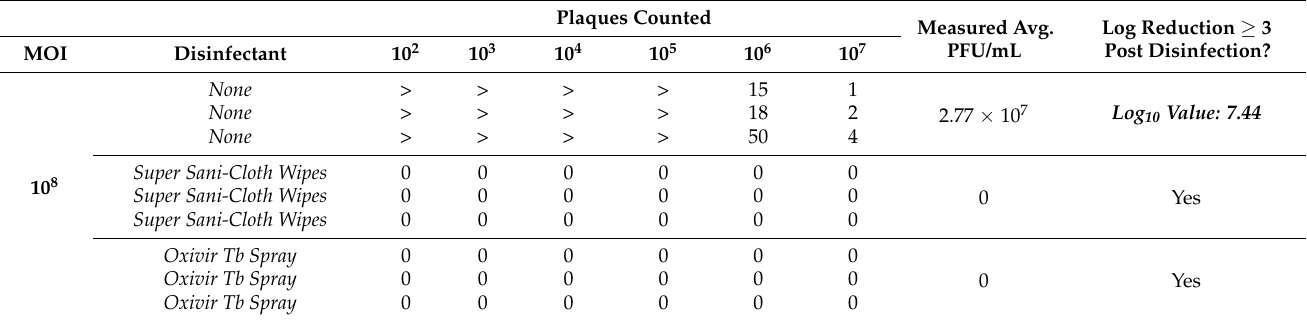
Table 1. Disinfection data for VSV-GFP 100 µ L spot on stainless steel.